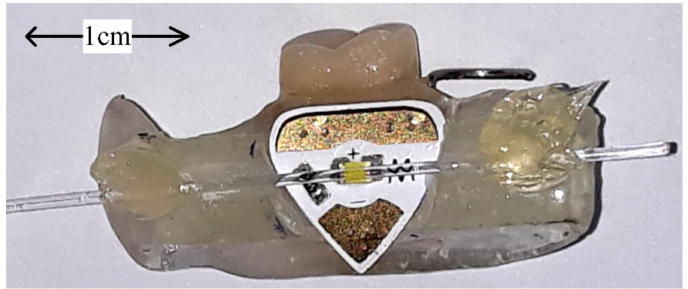
Figure 4. Practical realization of the point intra-oral sensor laboratory proof of concept, which has the LED source and the optical fiber from the sensor structure integrated into a lateral mouthguard.